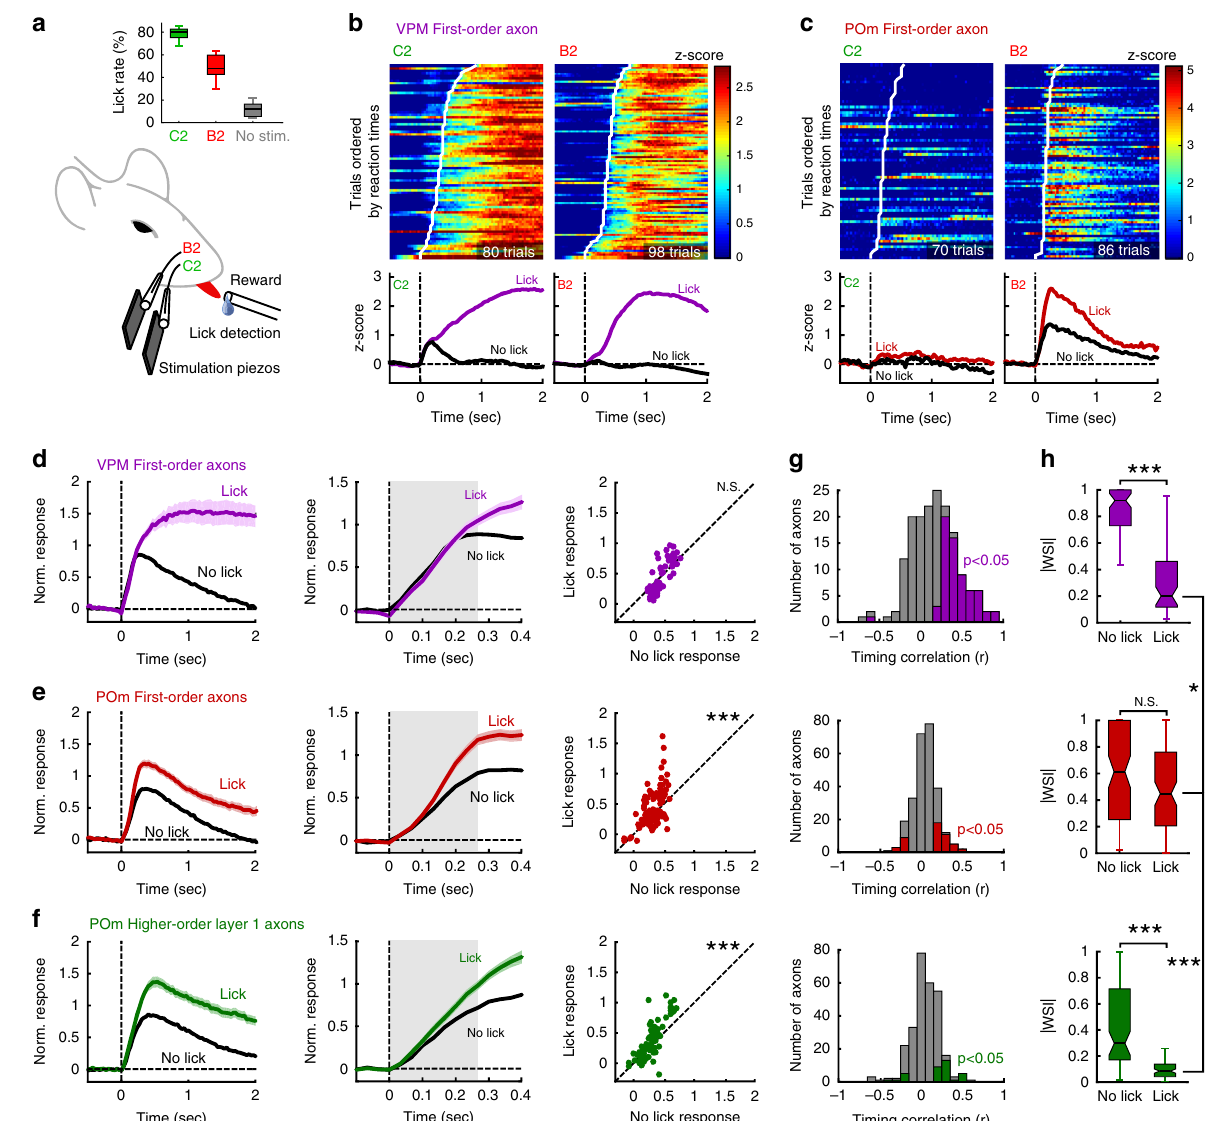
Fig. 4 Distinct sensory information in parallel thalamocortical pathways during goal-directed behavior. a Schematic of a mouse performing a two- whisker discrimination task, and the average lick rate over all imaging sessions (>4 days of training) for all stimulus conditions across mice (mean lick rates over n = 14 mice, Kruskal – Wallis test with Bonferroni correction: p = 0.02 for C2 vs. B2; p = 2 × 10 − 8 for C2 vs. No stim; and p = 0.009 for B2 vs. No stim). Boxplot: central mark indicates the median and edges indicate 25th and 75th percentiles. Whiskers extend to the largest or smallest point comprised within 1.5× of the interquartile range from both edges. b Calcium responses ( z -score) for an example VPM-FO axon during lick trials upon C2 or B2 whisker stimulation. Trials are ordered according to lick reaction times, which are shown with a white line on color maps. Average responses are shown below for lick and no-lick conditions. c Same as b , but for a POm-FO axon. d Left: Calcium responses averaged over all VPM-FO axons with signi fi cant responses to whisker stimuli during lick and no-lick trials, normalized to the no-lick condition. Dark lines: mean value and shaded areas: s.e.m. Middle: Early phase of the response over the fi rst 0.4 s. Right: Comparison of the response amplitude between lick and no-lick conditions averaged over gray area (0 – 0.266 s) in middle panel (Wilcoxon paired two-sided test, p = 0.94, N.S. not signi fi cant). e , f Same as d , but for POm-FO axons (*** p = 3 × 10 − 5 for ( e )) and POm-HO layer 1 axons (*** p = 1 × 10 − 5 for ( f )), respectively. g Distributions of Pearson correlation coef fi cient between reaction times and calcium response latencies for all axons with signi fi cant responses in lick trials ( n = 169 for VPM-FO, n = 264 for POm-FO, n = 281 for POm-HO layer 1 axons). Colored bars: Pearson coef fi cient with p < 0.05. h Distributions of whisker selectivity index absolute values comparing all axonal populations and lick/no-lick conditions for axons with signi fi cant sensory responses in no-lick condition (Kruskal – Wallis two-sided test with Bonferroni correction; VPM-FO: *** p = 1 × 10 − 12 for lick vs. no-lick, POm-FO: p = 0.32 for lick vs. no-lick N.S. not signi fi cant, POm-HO: *** p = 3 × 10 − 10 for lick vs. no-lick, * p = 0.034 for VPM-FO vs. POm-FO in lick condition, *** p = 5 × 10 − 15 for POm-FO and POm-HO in lick condition). Boxplot statistics as in ( a